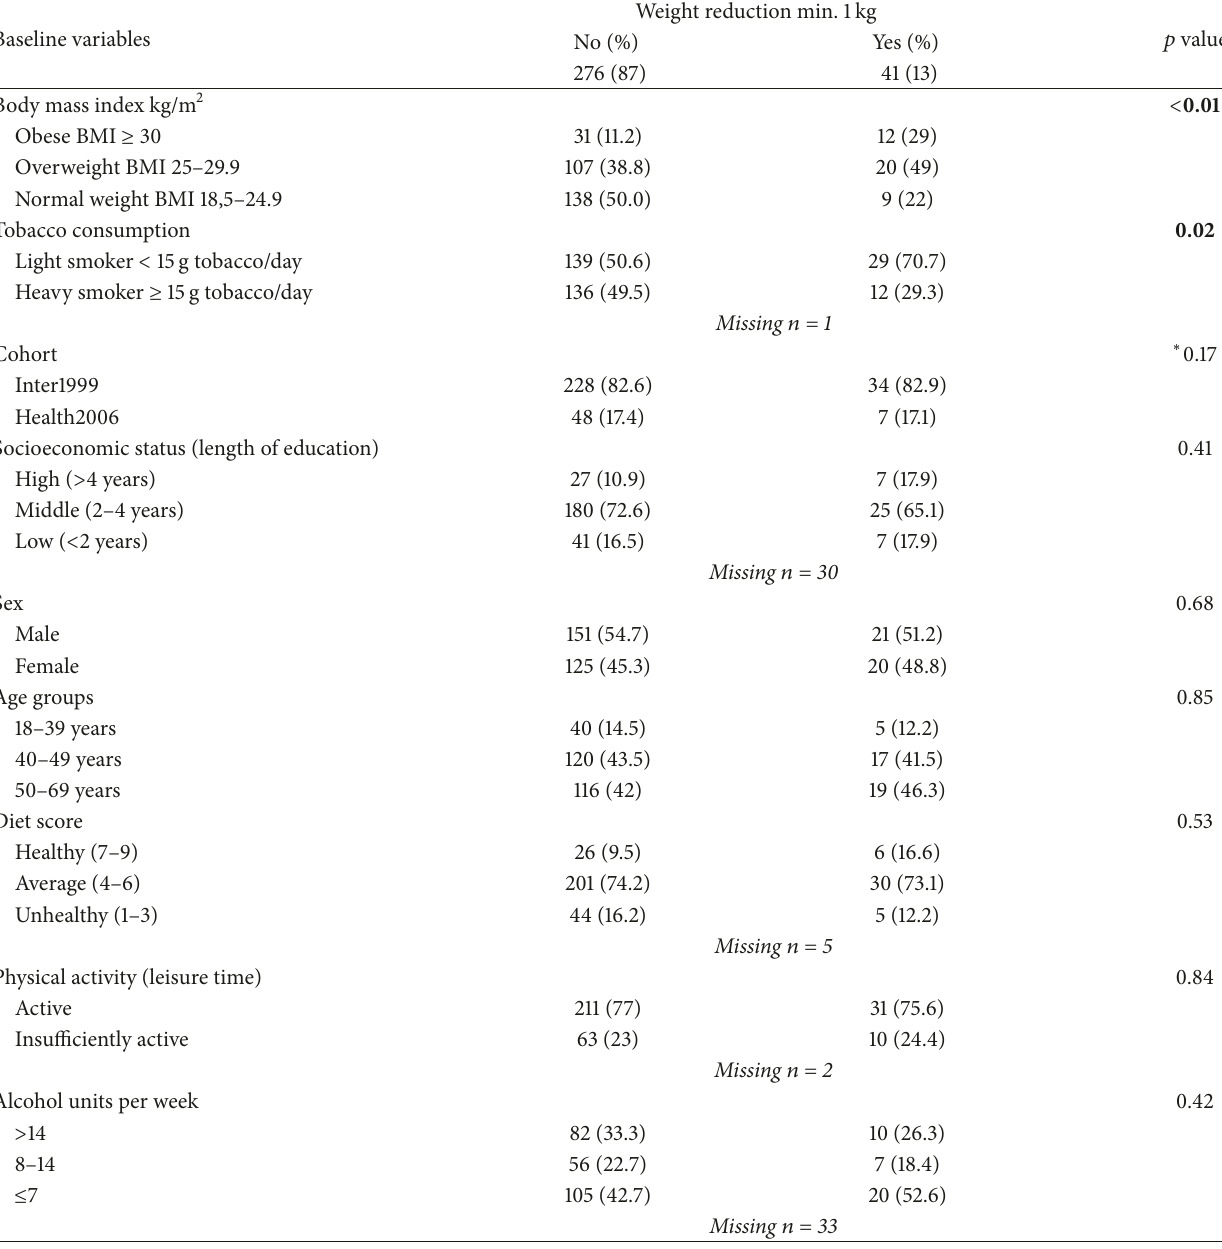
Table 1: Baseline characteristic of ex-smokers with long-term abstinence at five-year follow-up ( 𝑁 = 317 ). Baseline